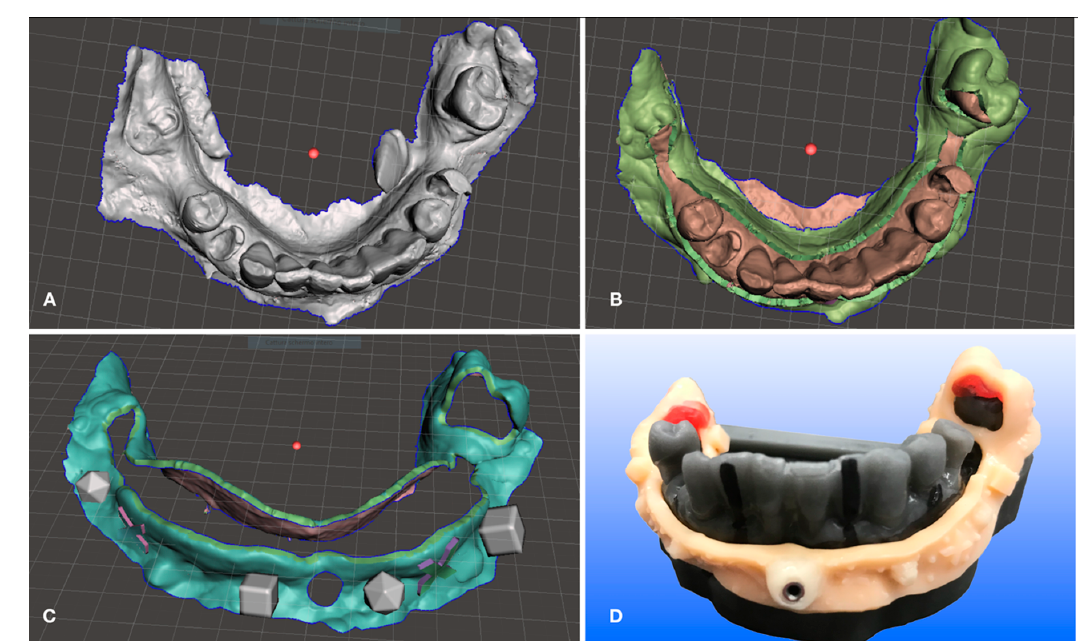
Figure 4. Design of the lower acrylic resin jig. ( A ) The digital lower scan is imported into Autodesk Meshmixer (Autodesk Inc., San Rafael, CA, USA) to design the digital index which will later serve to superimpose mandibular preoperative and postoperative scans. ( B ) The inferior digital index is designed in order to obtain stability thus proving occlusal clearance on all teeth but the lower second molars and providing the space for a frontal median stabilization pin. ( C ) Cubic and tetrahedral reference points are positioned to ease the match between the preoperative and the postoperative scan. ( D ) The digital